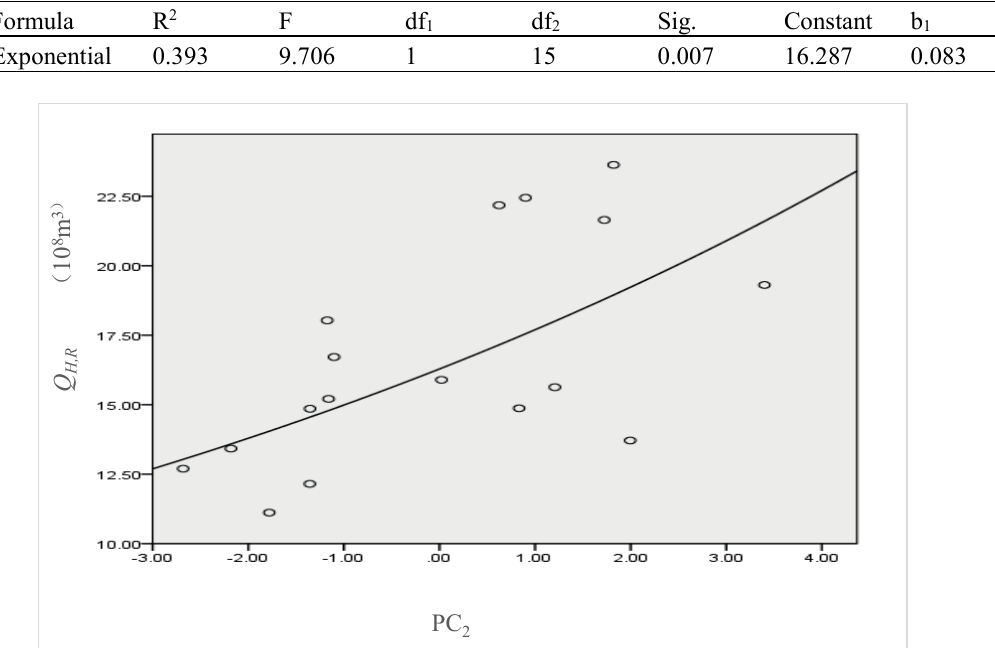
Table 3 Results of the curve fitting analysis.